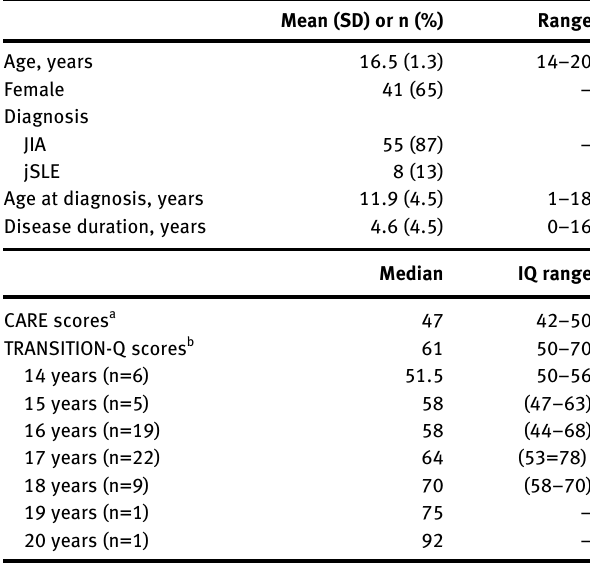
Table  : Baseline characteristics n=  .